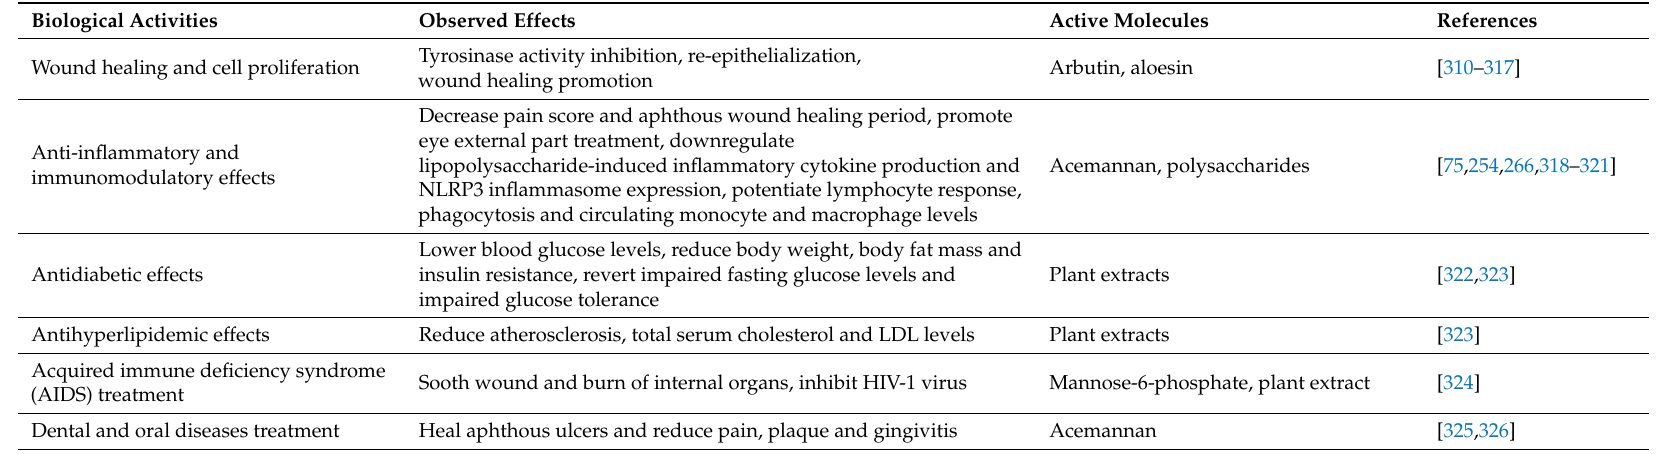
Table 7. Bioactive effects of Aloe plant species: clinical